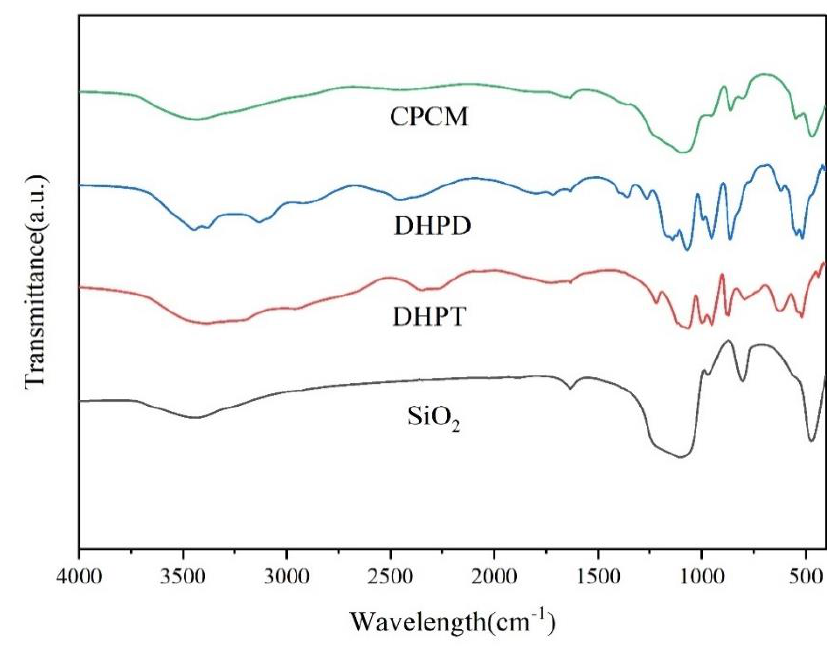
Figure 6. FT-IR spectra of SiO 2 , DHPT, DHPD, and composite PCMs.